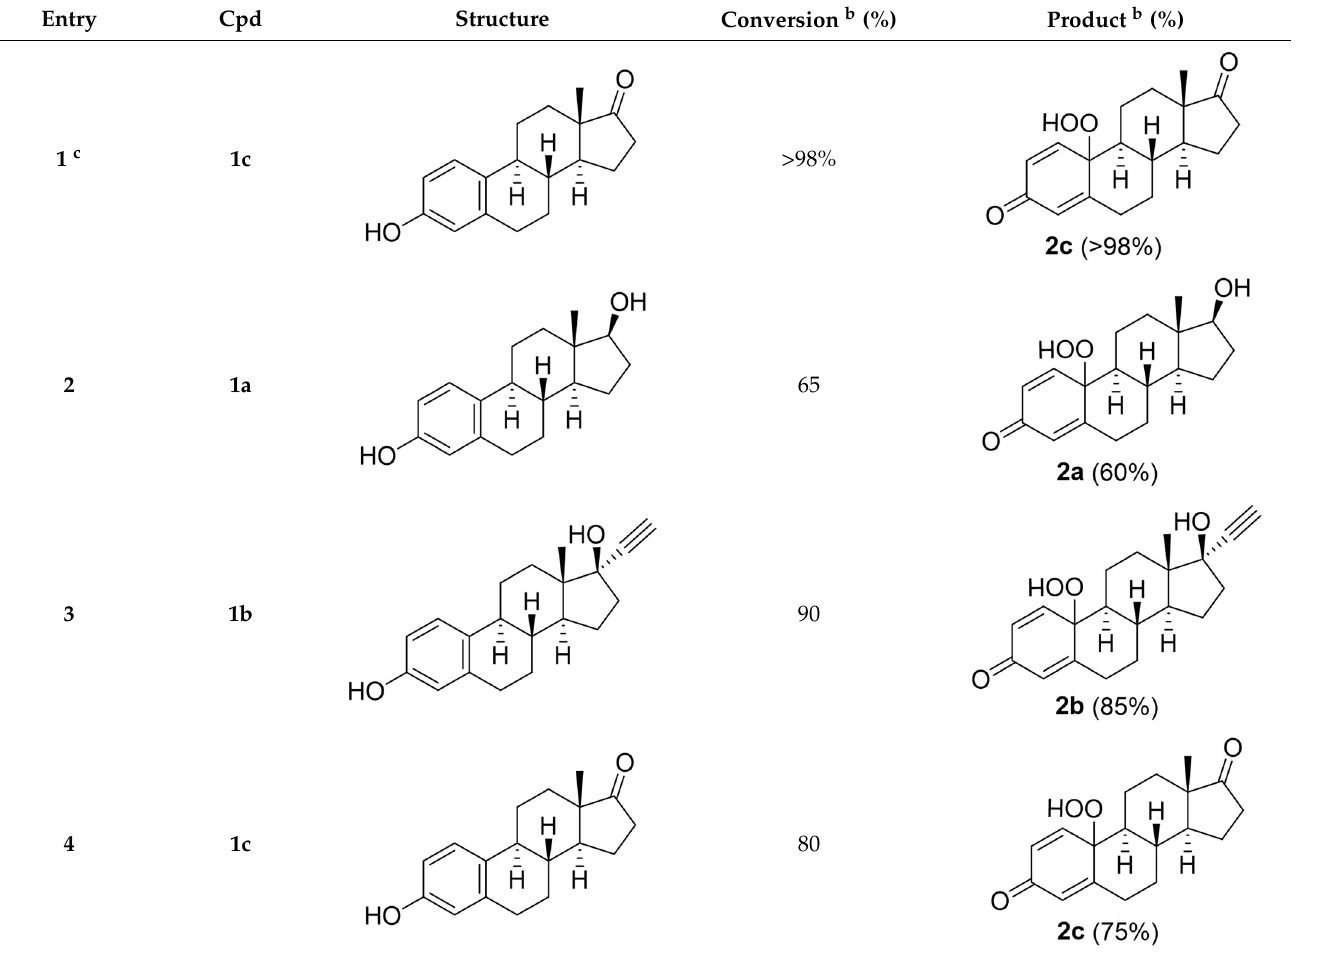
Table 2. Optimization experiments for the synthesis of hydro-peroxide 2b a .